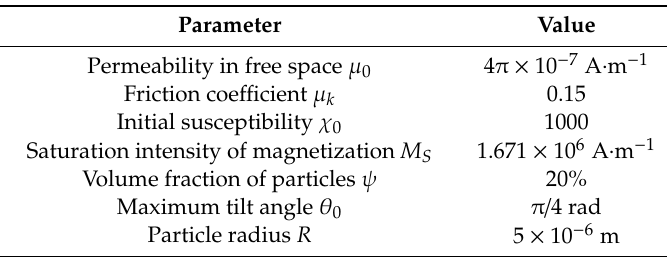
Table 3. Calculation